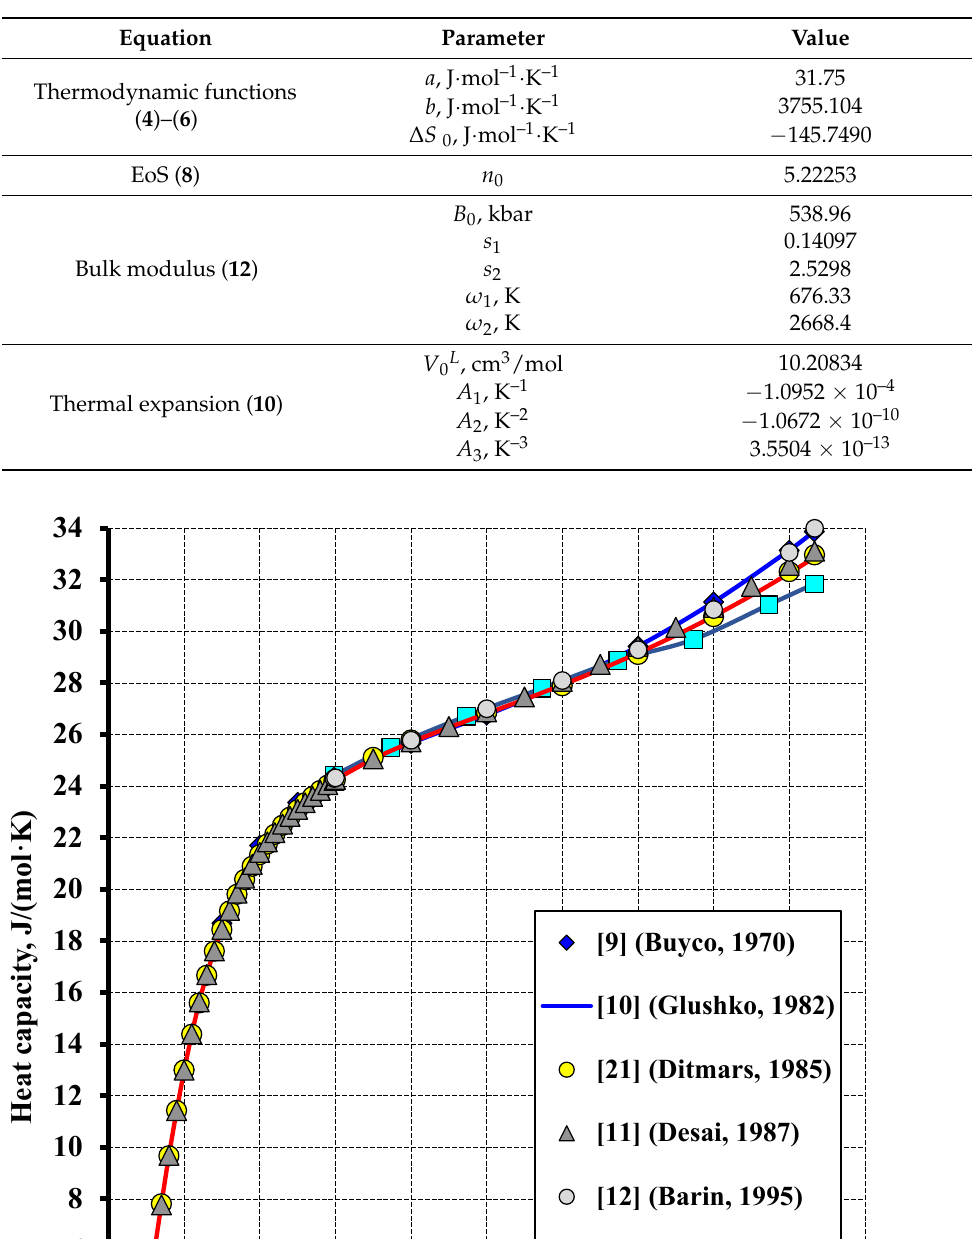
Table 4. A summary of optimized variables of the EoS for liquid aluminum.